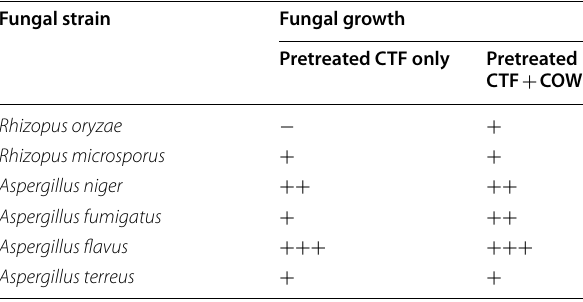
Table 1 Fungal growth of different fungal strains on pretreated CTF with and without